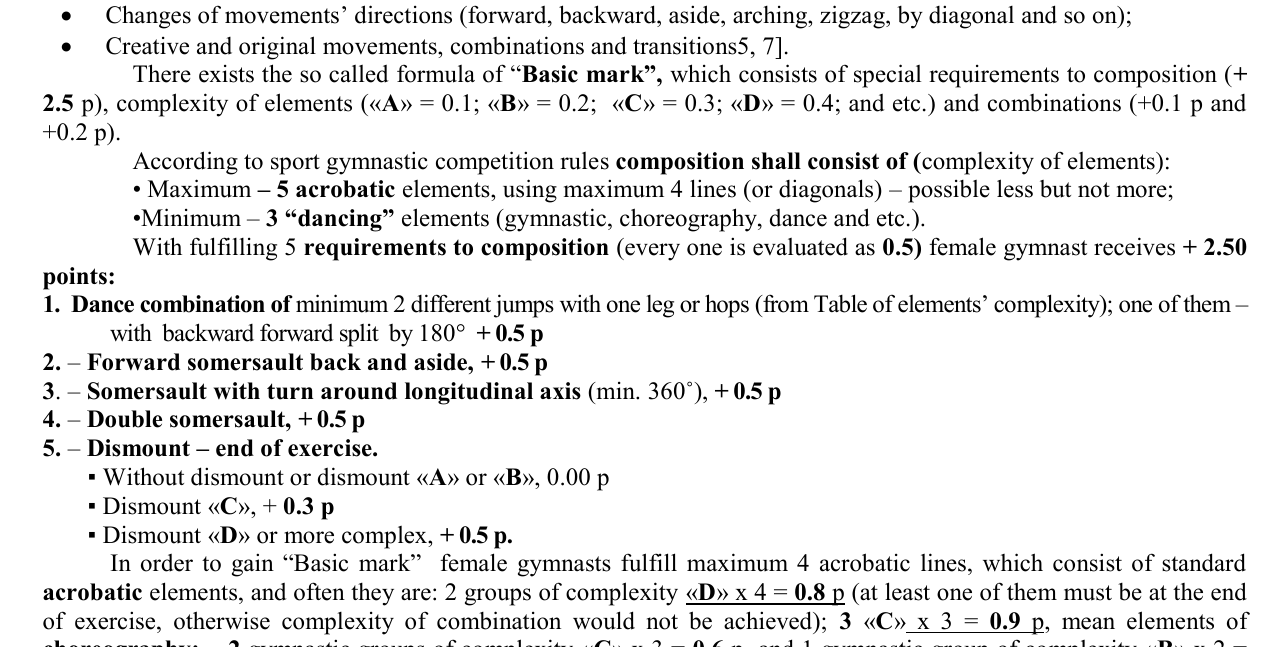
choreography: − 2 gymnastic groups of complexity « C » х 3 = 0.6 p and 1 gymnastic group of complexity « В » х 2